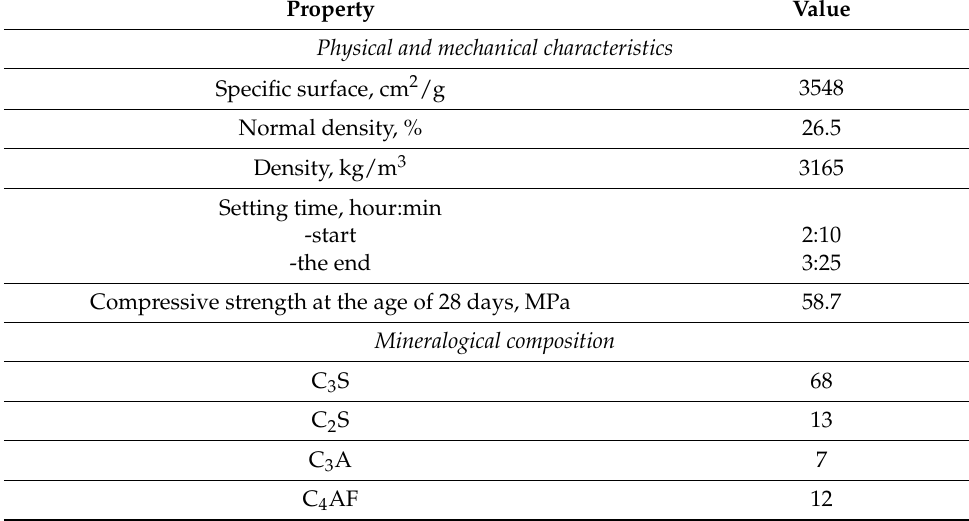
Table 2. Physical and mechanical characteristics and mineralogical composition of cement.